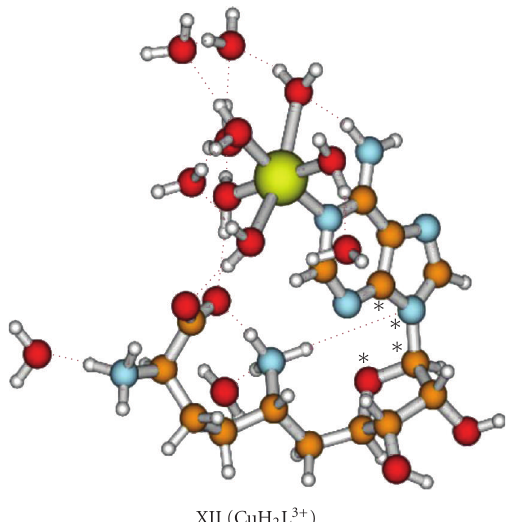
Figure 4: The lowest energy structure of CuH 2 L 3+ complex. The angle O–C–N–C defining the position of adenine group is marked with